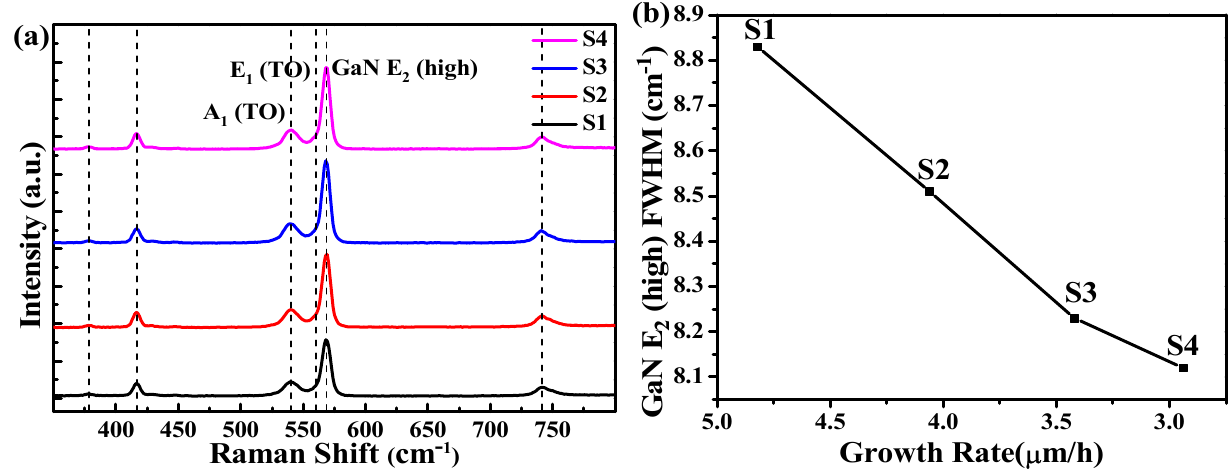
Figure 5. ( a ) The RT Raman scattering spectra for all the semi-polar (11 2(cid:3364) 2) GaN samples. ( b ) GaN E 2 (high) FWHM (cm −1 ) at different growth rate. Figure 6a shows the line profiles extracted from the AFM micrograph along [ 11(cid:3364)(cid:3364)(cid:3364)(cid:3364) 23] (red) and [1 1(cid:3364) 00] (green) directions and (b) examples of their corresponding line profiles